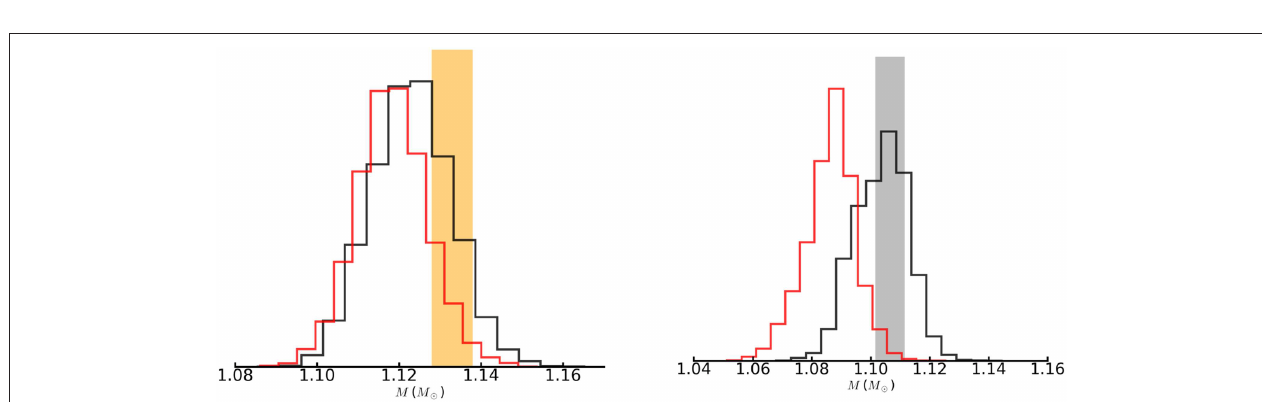
FIGURE 1 | Run I (Left) and Run II (Right) : Histograms represent the stellar mass posterior PDFs obtained using Grids A (red) and B (black). The dynamical masses (and corresponding uncertainties) of Pourbaix and Boffin (2016) and Pourbaix et al. (2002) are shown in orange and gray, respectively.